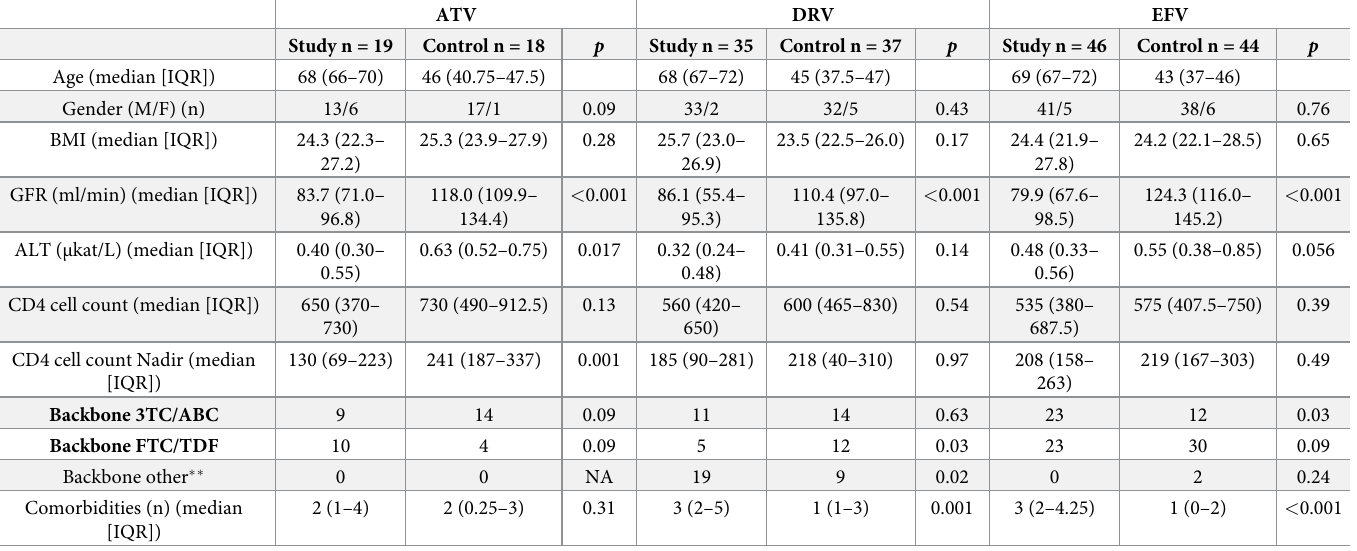
Table 1. Baseline